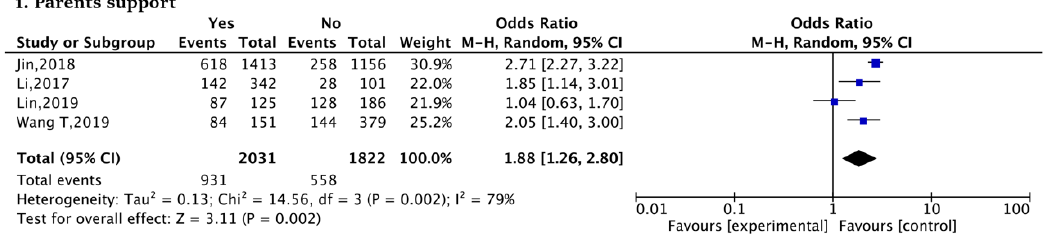
Figure 6. Forest plots of parents or others factors.